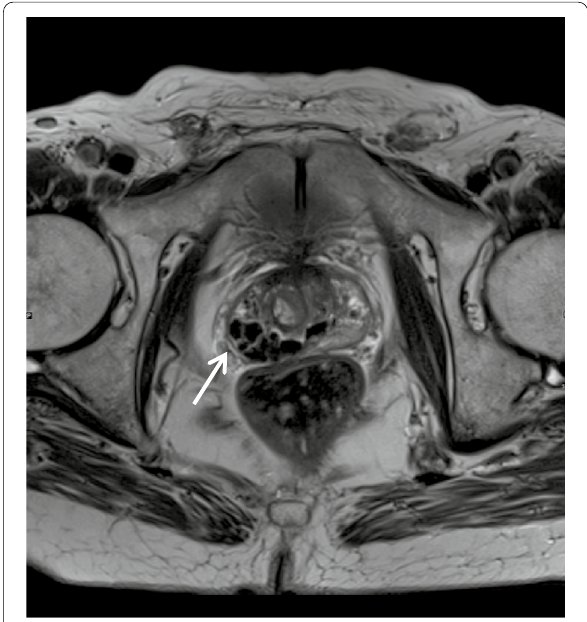
Fig. 2 Prostate calcification Axial T2W image shows well-defined low T2 signal lesions in the right posterolateral prostate in keeping